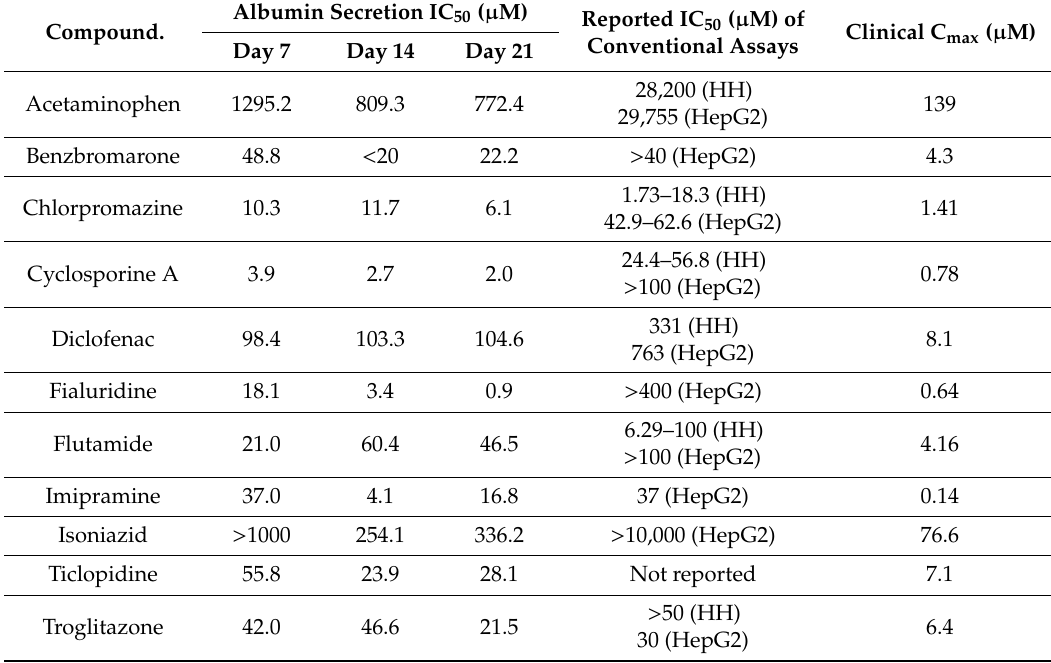
Table 3. Comparison of IC 50 values for albumin secretion between PHH spheroids and conventional assays.